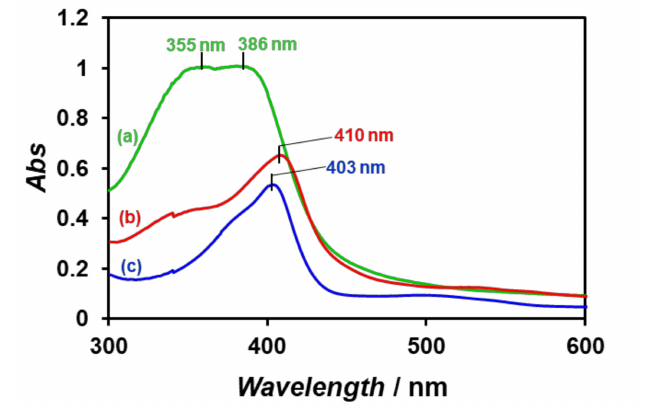
Figure 7. UV-Vis spectra of ( a ) hemin (24 mM), ( b ) His-tagged HRP (0.2 mg / mL), and ( c ) commercially available HRP (0.2 mg / mL) in 10 mM Tris-HCl bu ff er (pH